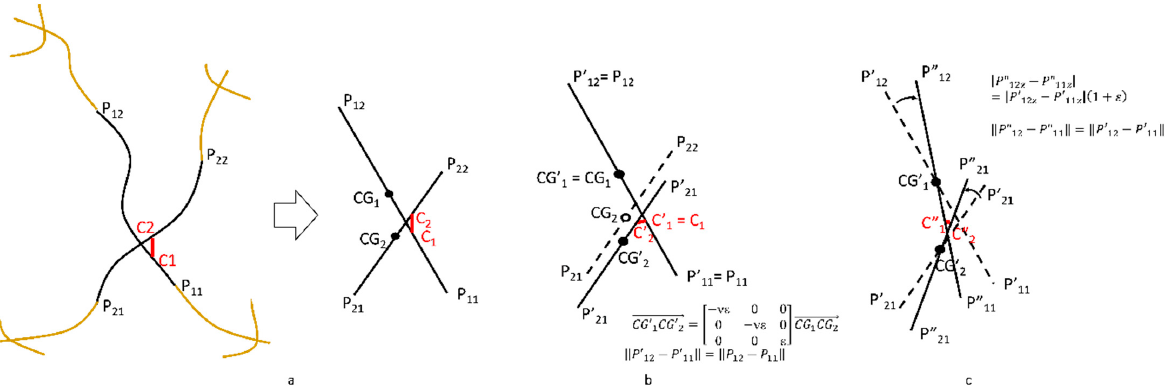
Figure A2. ( a ) A deformation element and its representation by two straight lines; ( b ) displacement of the centers of gravity; ( c ) rotation of straight sections.